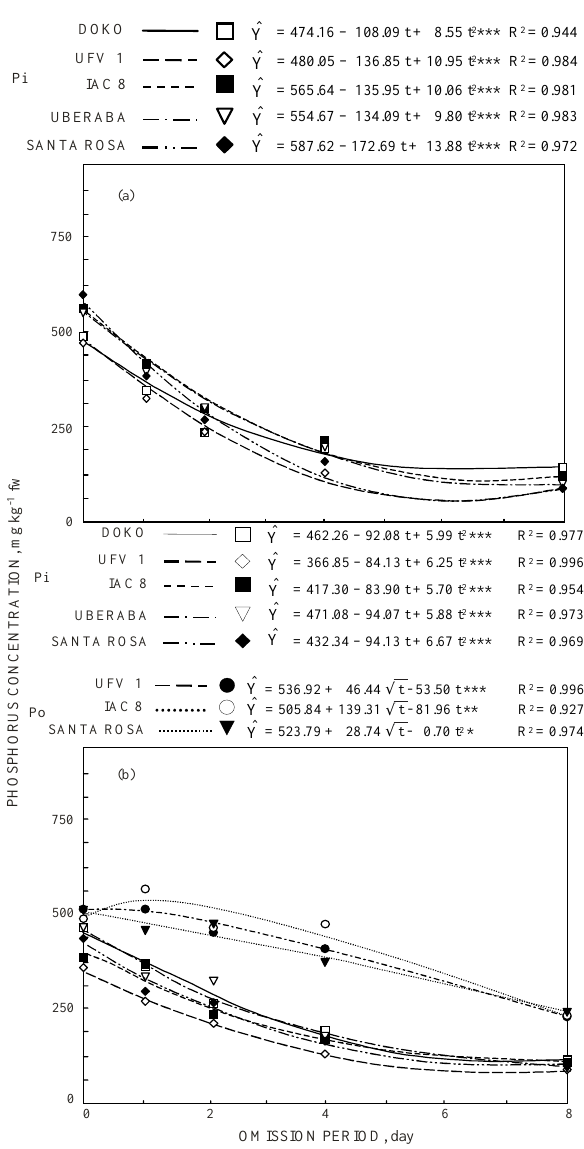
Figure 2. Inorganic P (Pi) and organic P (Po) concentration in fresh matter of the upper leaves (a) and middle leaves (b) of five soybean cultivars as a function of the P omission period. (*, **, ***: Significant at 10,5 and 1 %,